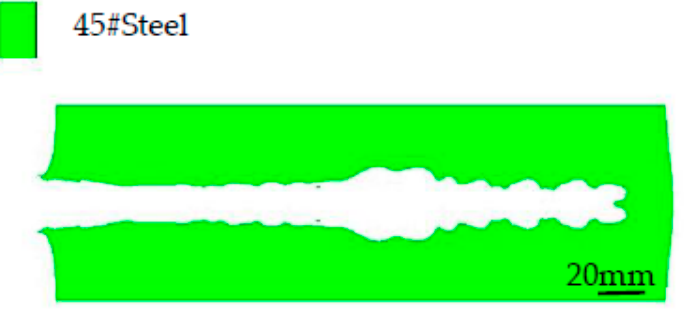
Figure 17. Numerical simulation of opening morphology.